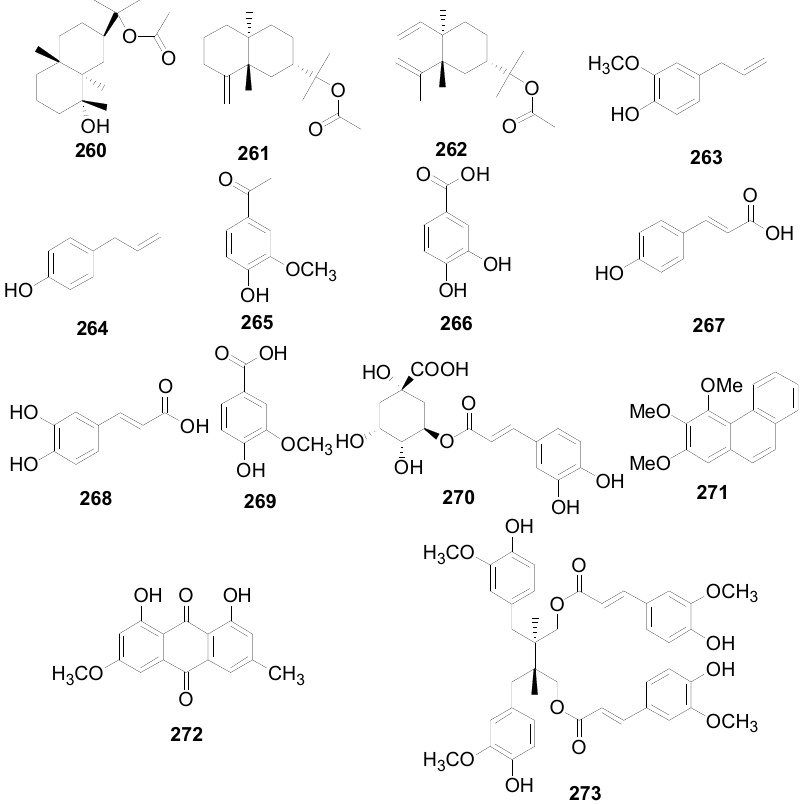
Figure 13. Structures of compounds 260 – 273 .